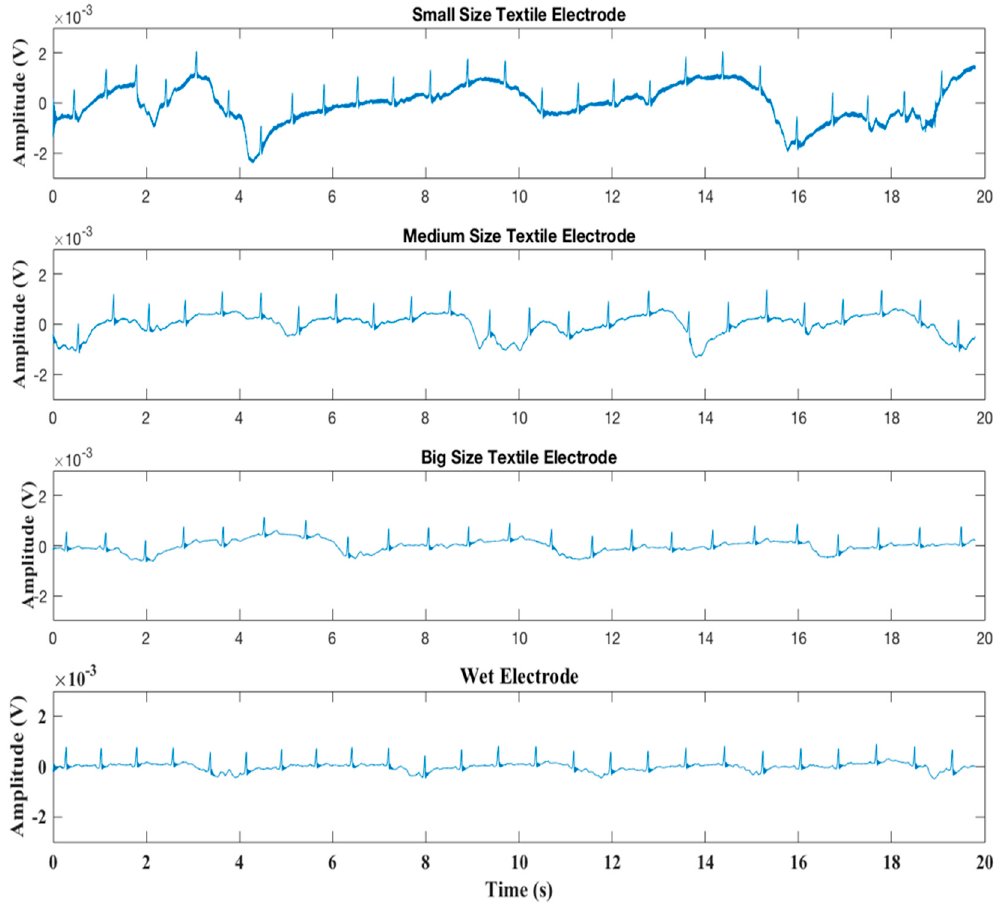
Figure 9. Resting electrocardiogram (ECG) signals recorded by different electrodes.